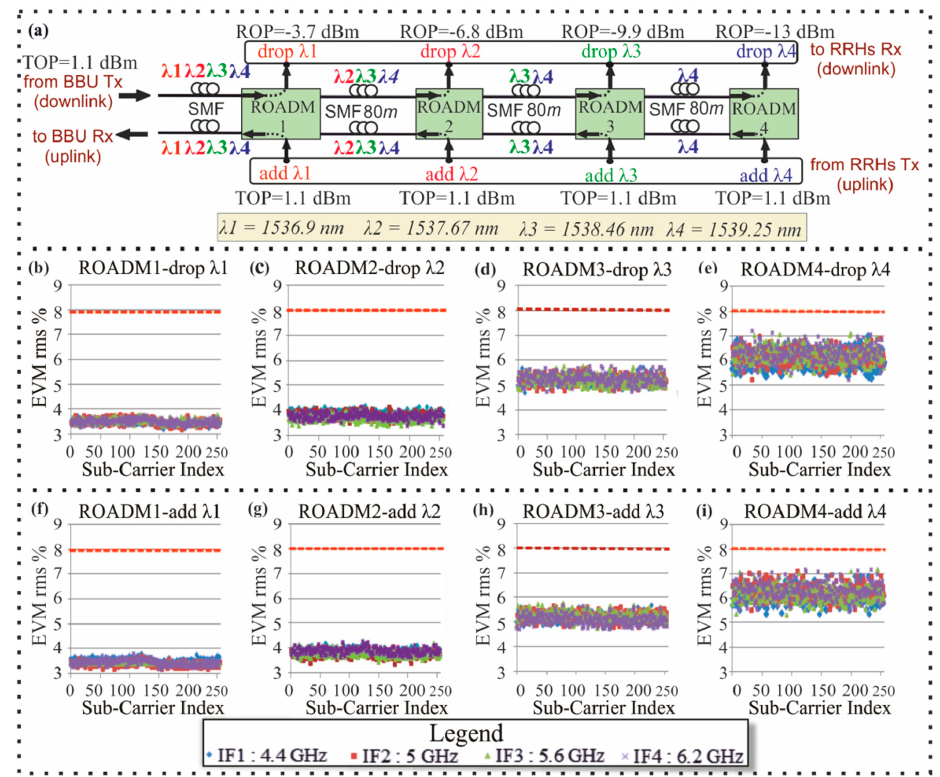
Figure 8. ( a ) Simulation setup of the WDM downlink and uplink optical bus where downlink λ 1 , λ 2 , λ 3 , λ 4 data signals are subsequently dropped by ROADMs 1–4 and uplink λ 4 , λ 3 , λ 2 , λ 1 data signals are subsequently added by ROADMs 4,3,2,1, respectively. EVM per SC for all IF bands for the ( b ) downlink WDM1 ( λ 1 = 1536.9 nm) at a ROP of − 3.7 dBm, ( c ) downlink WDM2 ( λ 2 = 1537.67 nm) at a ROP